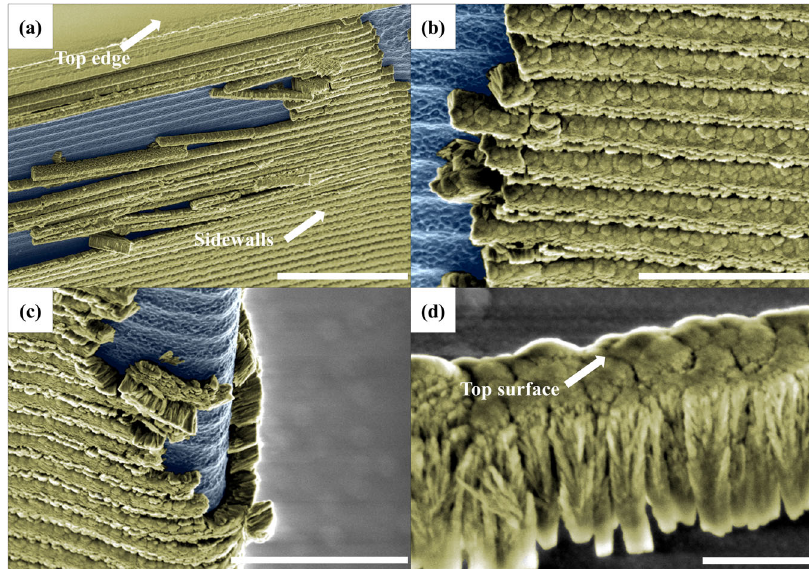
Fig. 3 SEM images of an ALD/ICPCVD-protected device after 5 min KOH etching, showing silicon surfaces (blue), and SiO 2 protection layers (yellow). a The protection layer collapsed in “ strips, ” starting from near the top. The scale bar is 10 µm. b The boundary between exposed silicon and SiO 2 protection fi lm shows an abrupt interface. The scale bar is 3 µm. c Closer view at the front edge of the device tip. The scale bar is 5 µm. d High magni fi cation view of a dislodged SiO 2 strip. The scale bar is 500